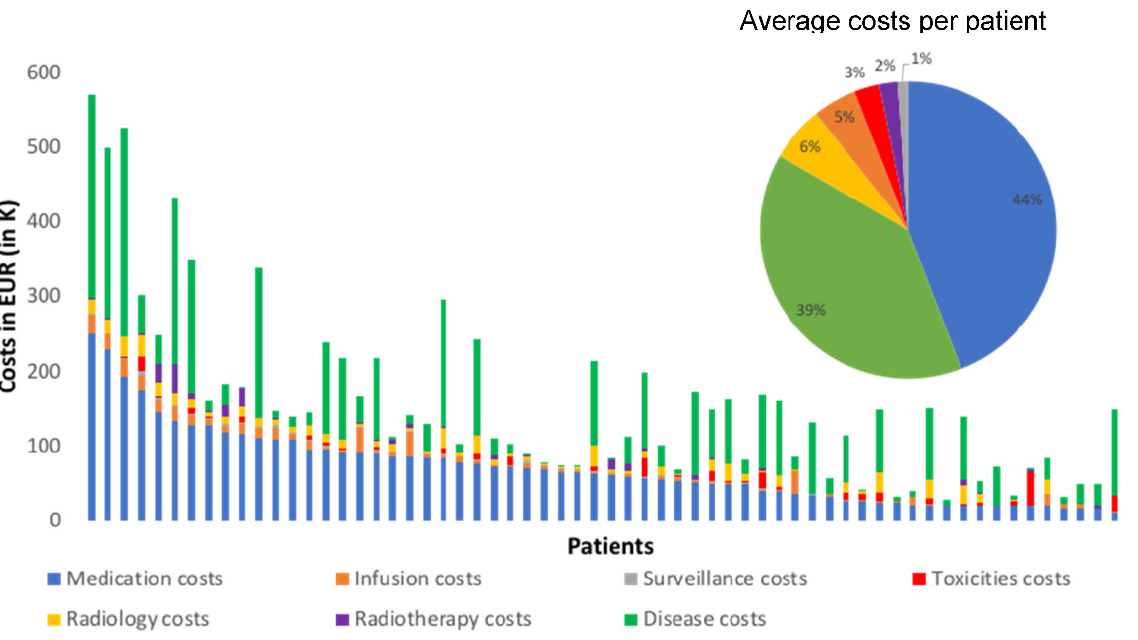
Figure 4. Total cost per patient with contributions of the cost categories defined in Table 1. Inset: average proportion of each cost category over the whole cohort (same color code as main graph).